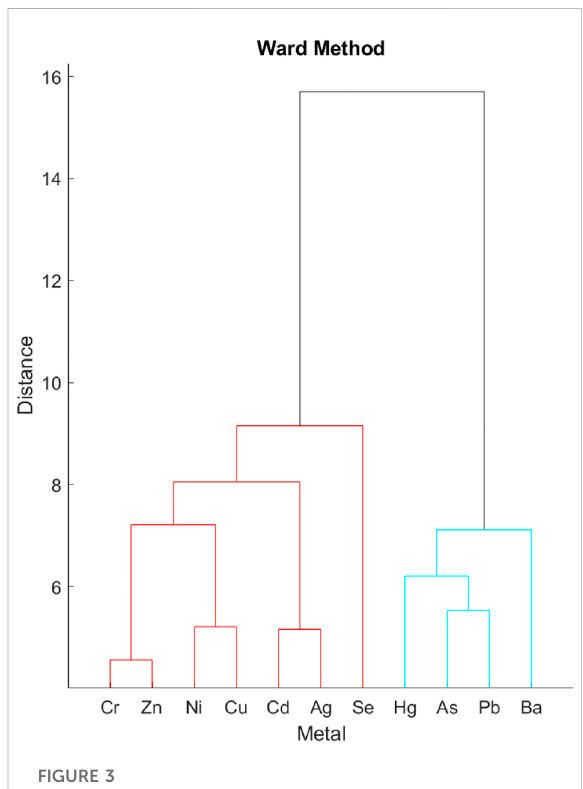
FIGURE 3 Dendrogram of trace metals. Colored groups indicate cluster separation at 70% maximum linkage distance (~11).